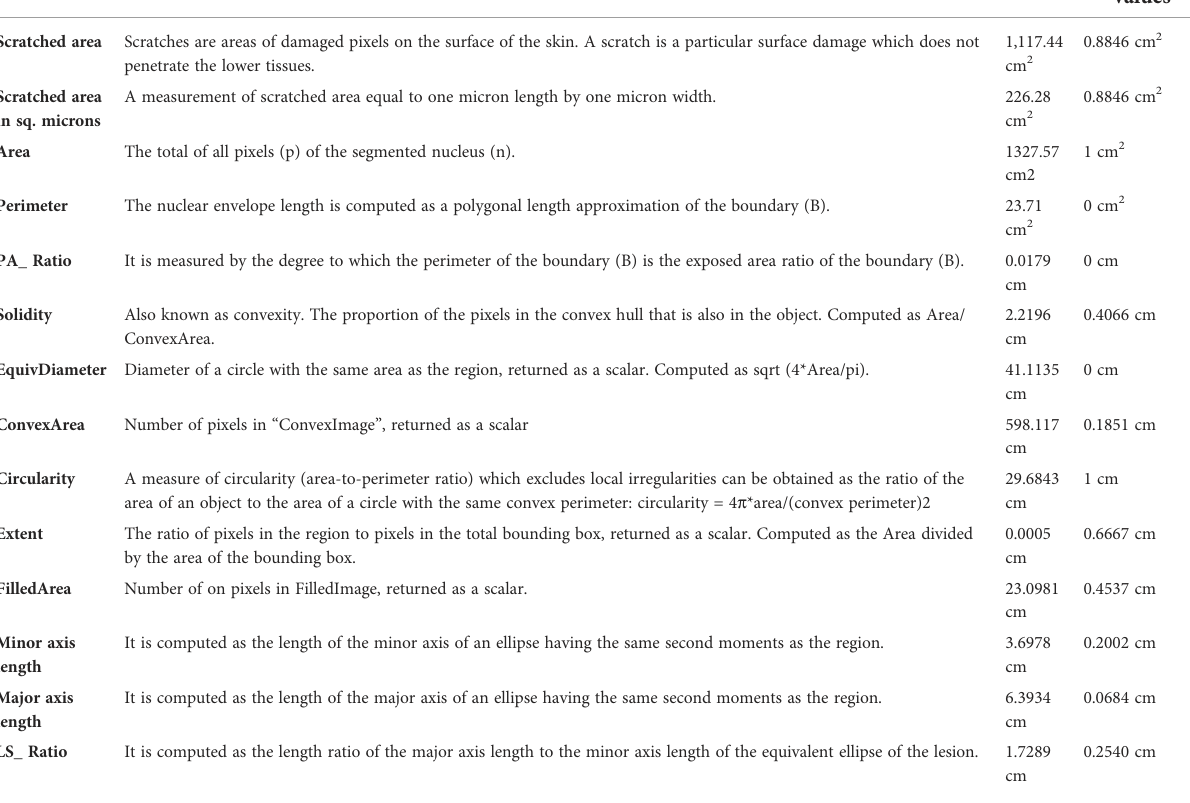
TABLE 4 A detailed explanation of geometrical